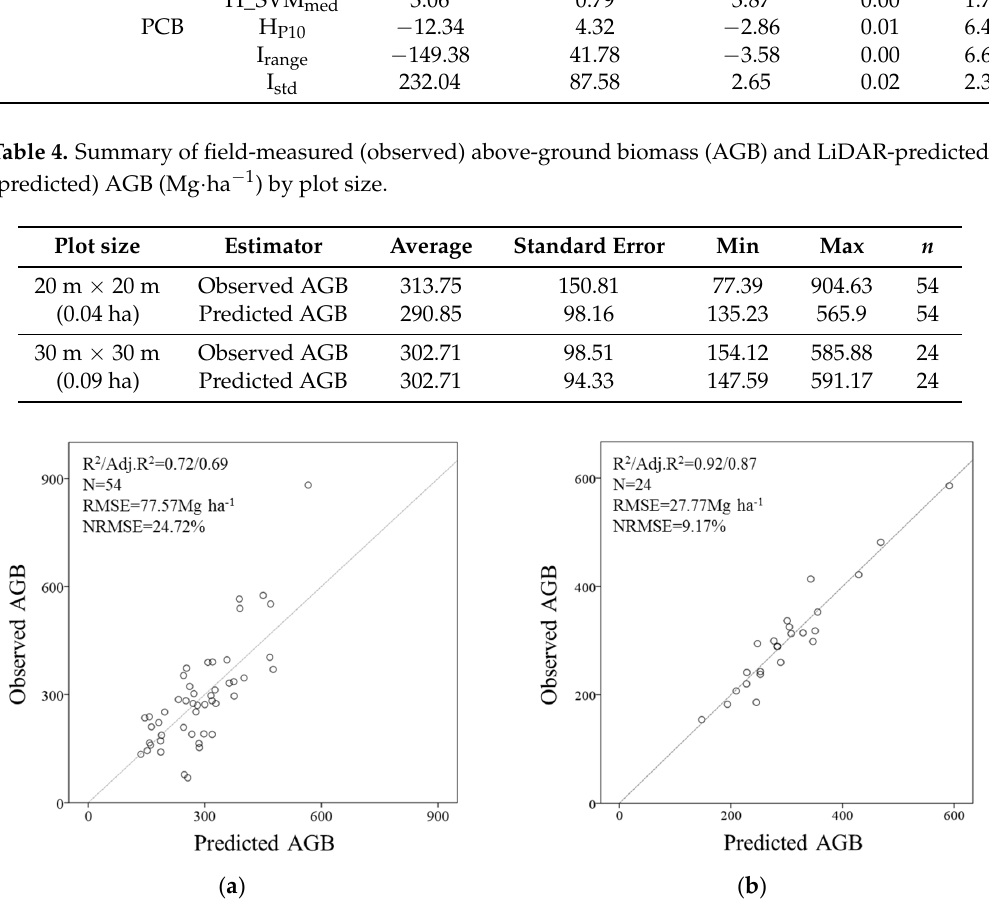
Figure 6. Comparison of predicted and observed AGB for the accuracy assessment of the regression model derived from ( a ) 20 m × 20 m plots and ( b ) 30 m × 30 m plots. Table 3. Results of multiple regression analysis on 20 m × 20 m and 30 m × 30 m plot size.